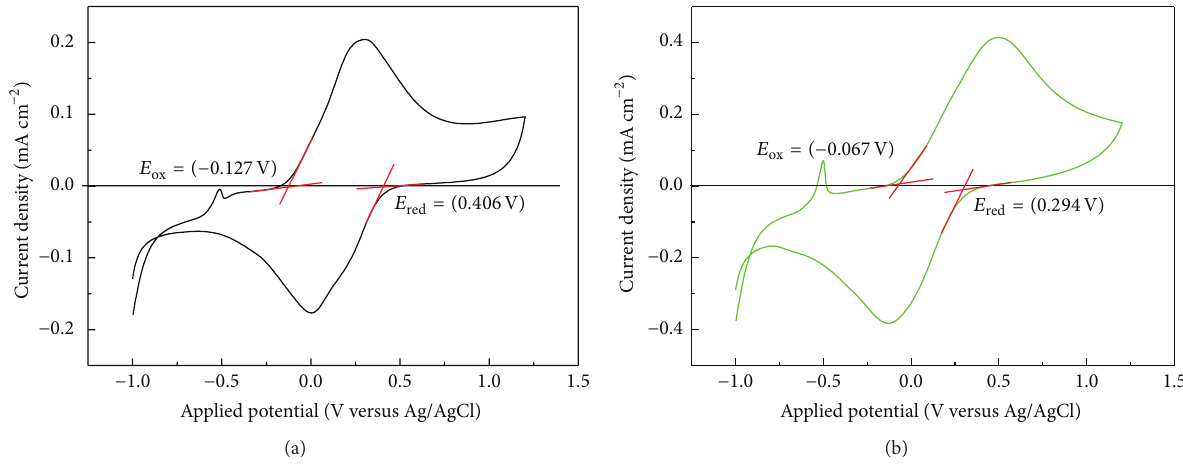
Figure 4: Voltammograms of (a) PPy-IC and (b) PPy-IC-Ag nanop films in 0.1 molL −1 LiClO 4 aqueous solution at a scan rate of 50mVs −1 .